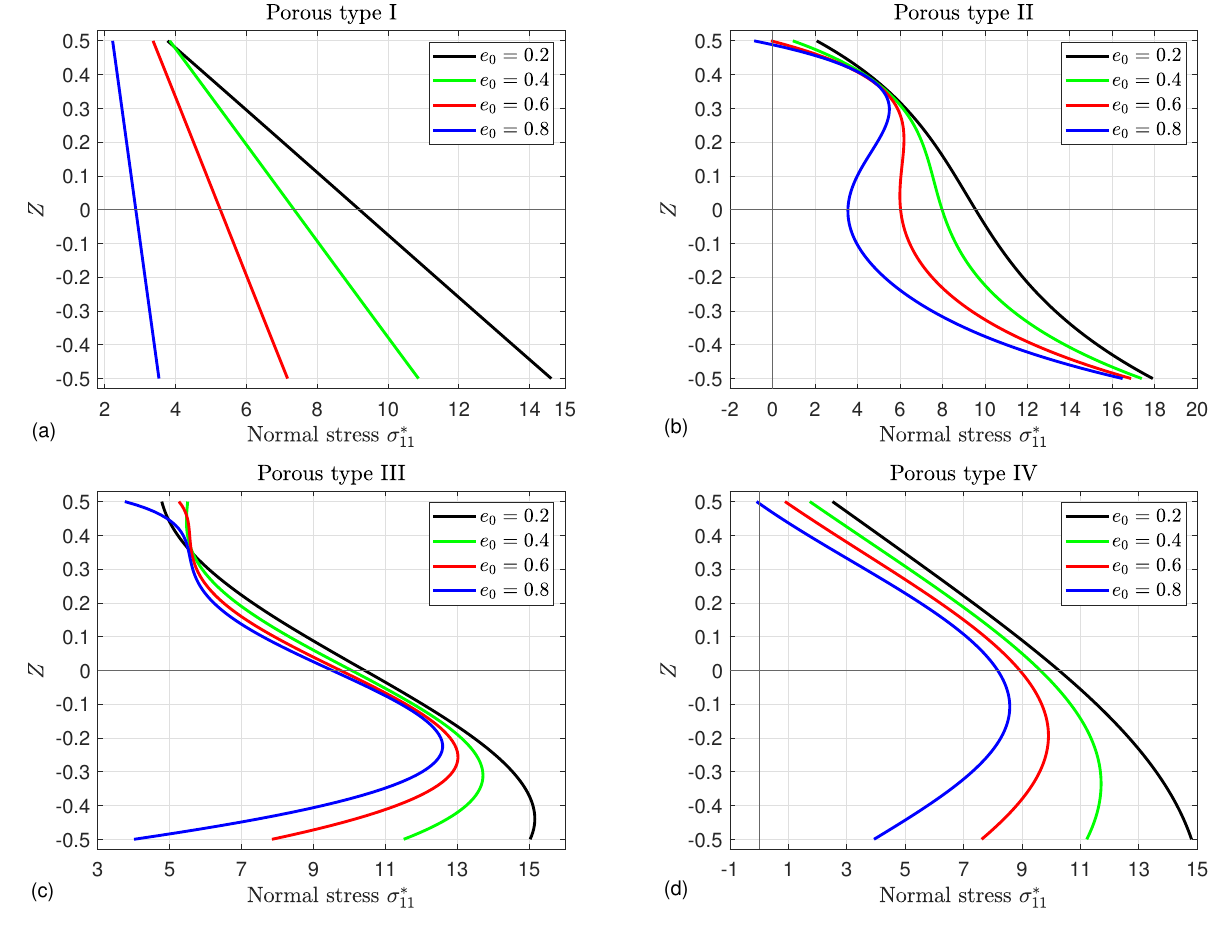
in FG porous nanocomposite 11